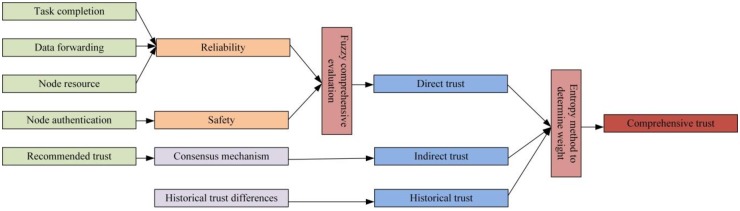
TrustBlock trust evaluation system.